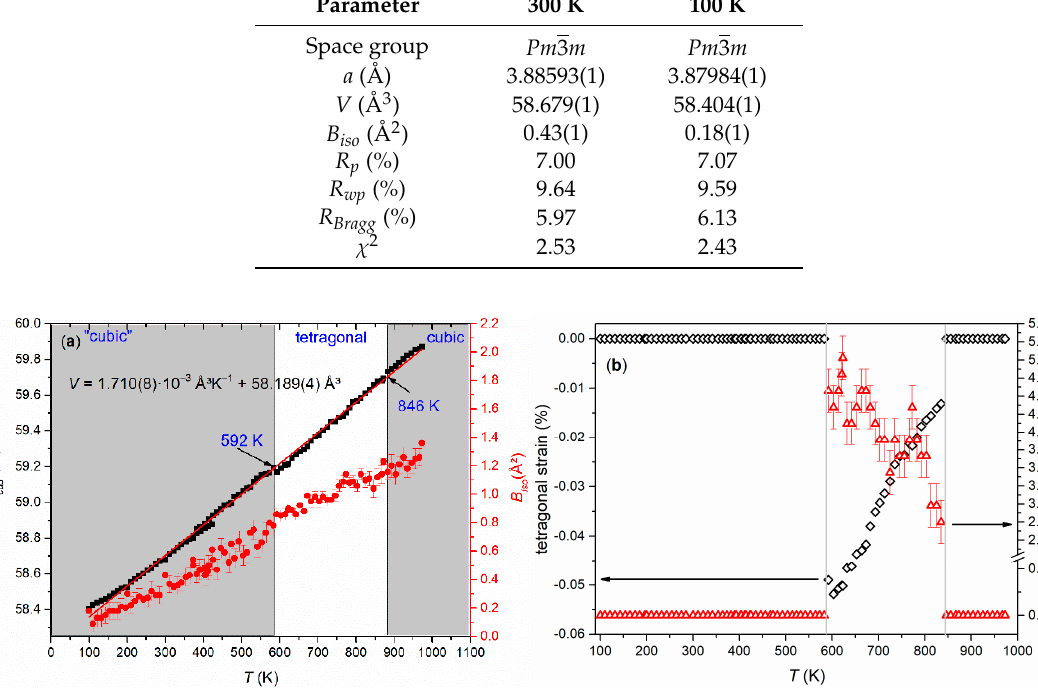
Eu 0.8 Ca 0.2 TiO 3– δ together with the refined overall B iso values (red dots) and ( b ) tetragonal strain